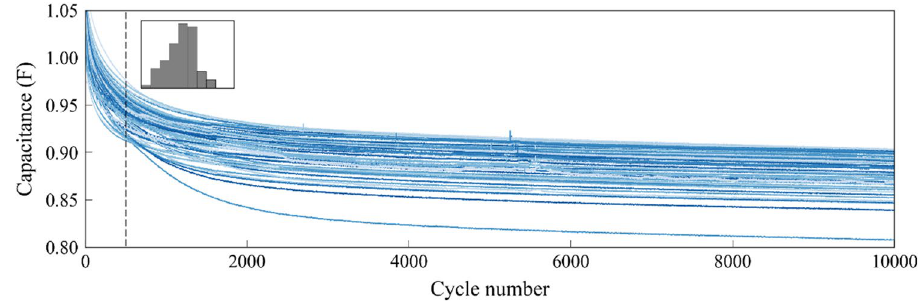
Figure 2. SOH trajectories of SCs as a function of cycle number, calculated from the preliminary data set. The inset shows the distribution of capacitance at 500th cycle which approximates the Gaussian distribution.